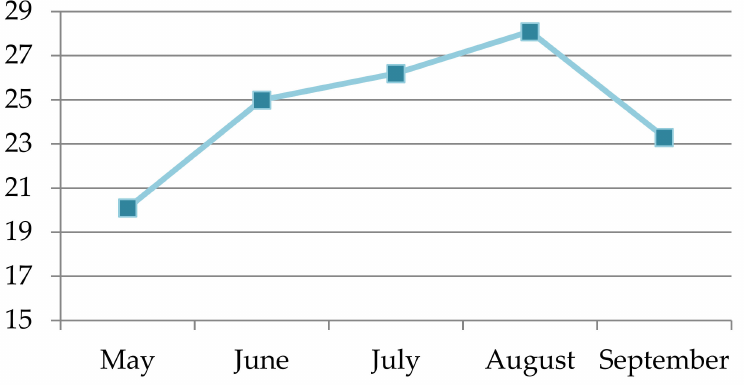
Figure 11. Sea temperature measured during